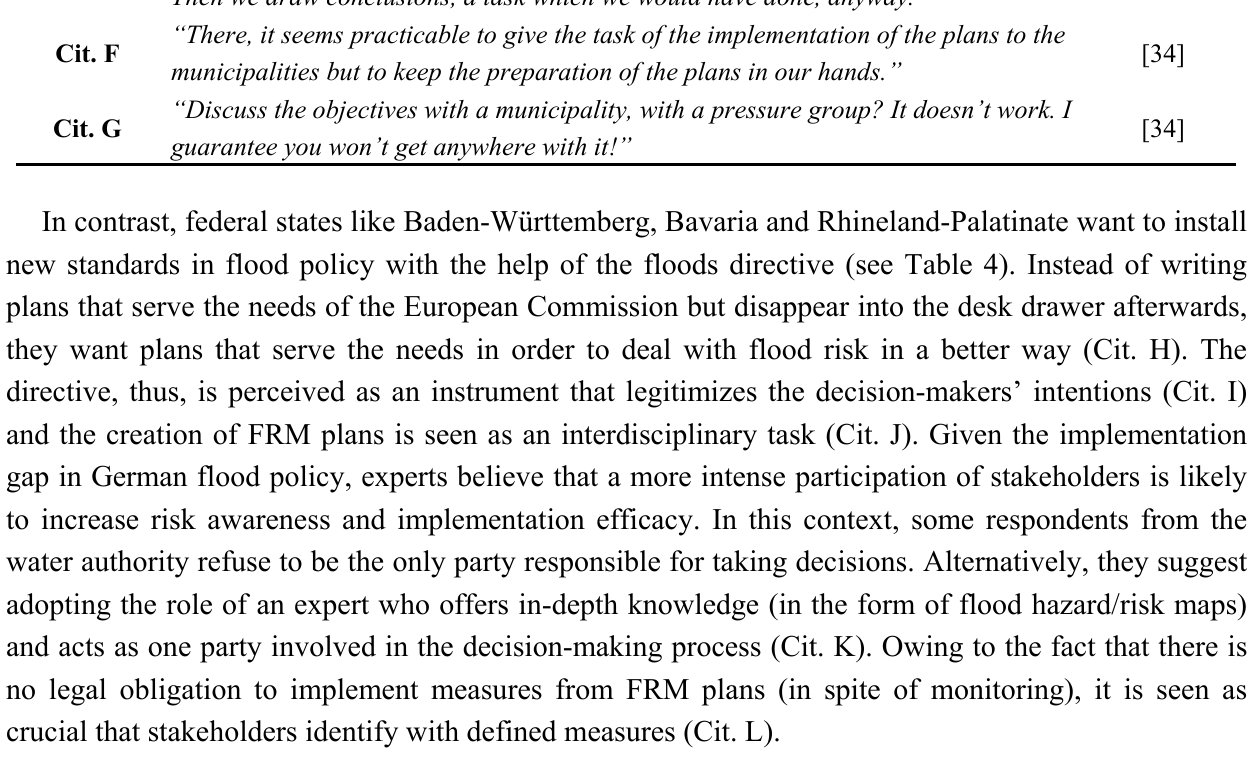
Table 4. Citations reflecting intentions to seize the chance to remodel flood